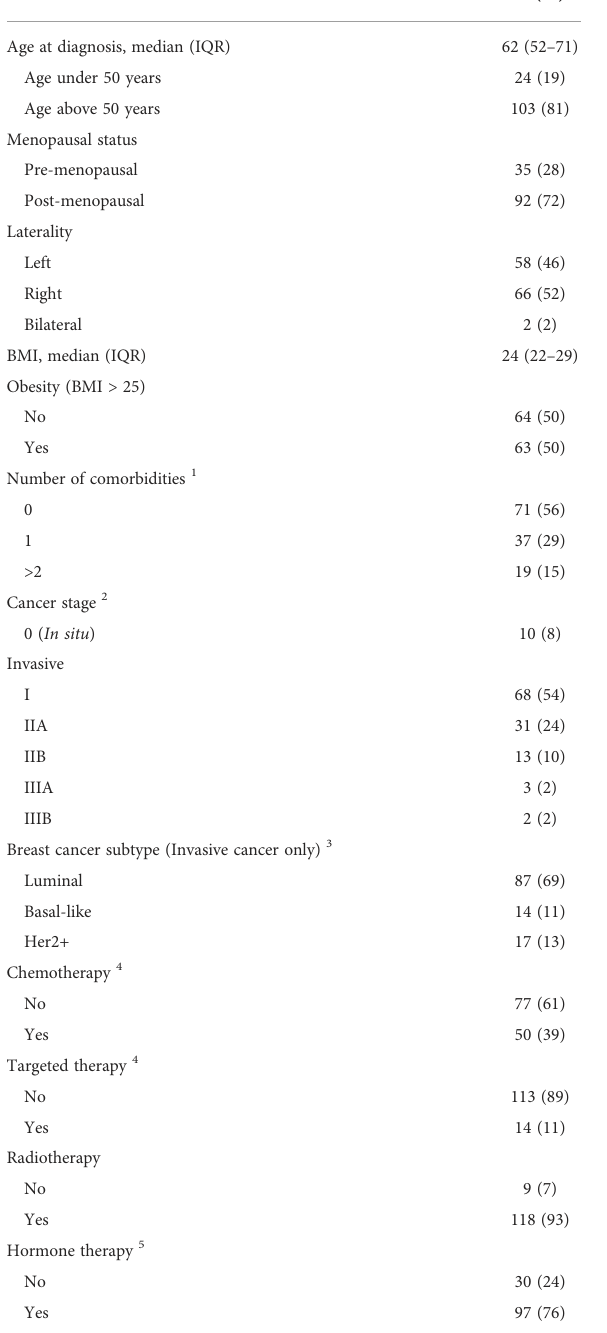
TABLE 1 Patient characteristics (N =